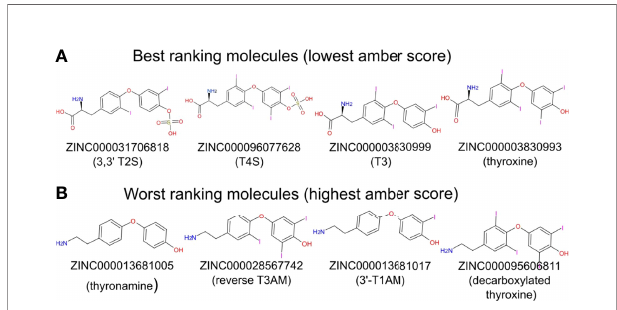
FIGURE 2 | Two-dimensional structure of molecules having the best and worst Amber score. (A) The four molecules showing the best (lowest) Amber score. (B) The four molecules showing the worst (highest)